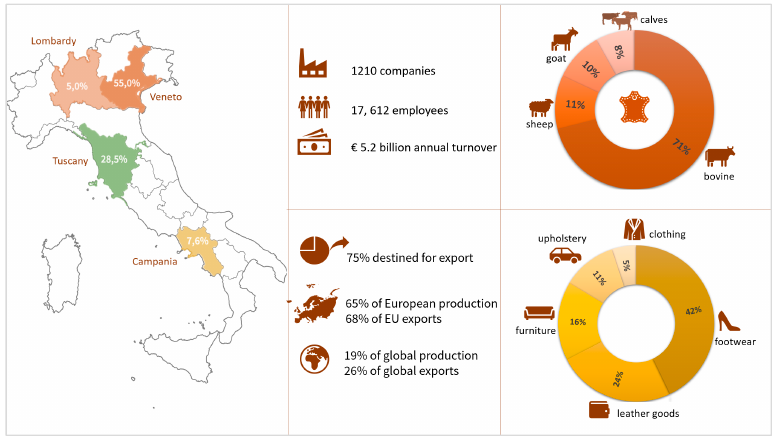
Figure A1. Italian leather industry in a nutshell [80].